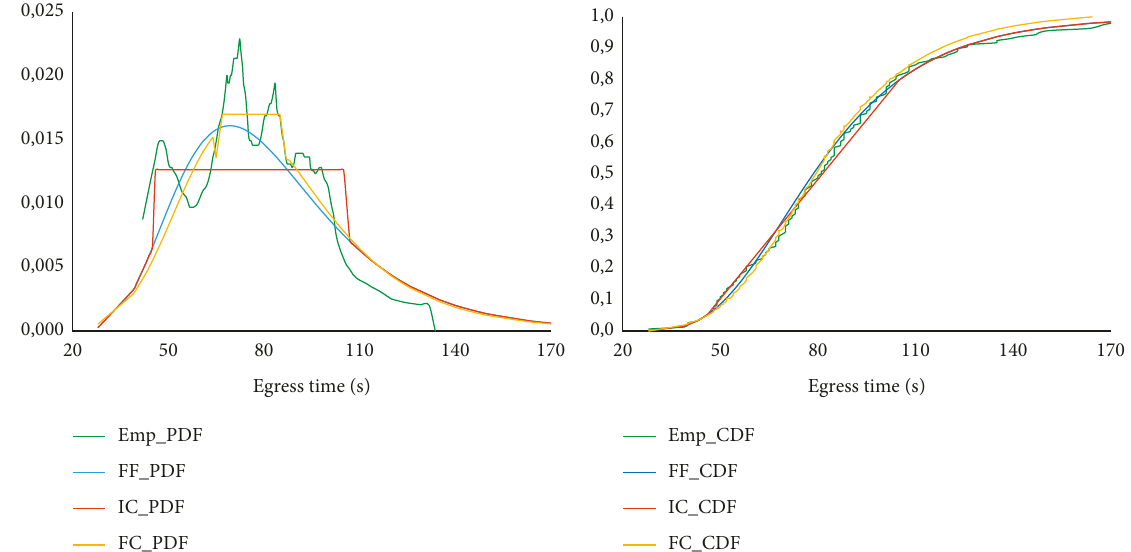
Figure 7: PDF (a) and CDF (b) of egress times for the train at 18:32